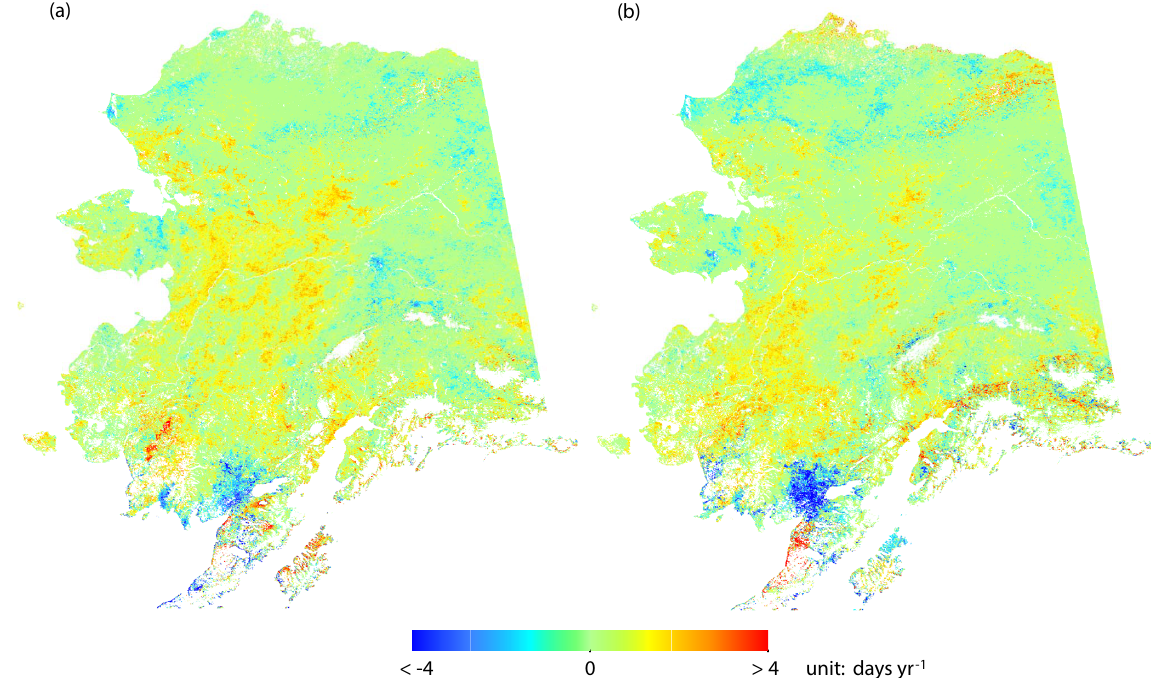
Figure 6. Recent trends (daysyr − 1 , 2001–2015) in the annual snow-free period derived from the MODIS snow cover extent (SCE) product (MOD10A2, a ) and the MERRA-2 snow depth data after filtering using the MOD10A2 SCE observations (b)